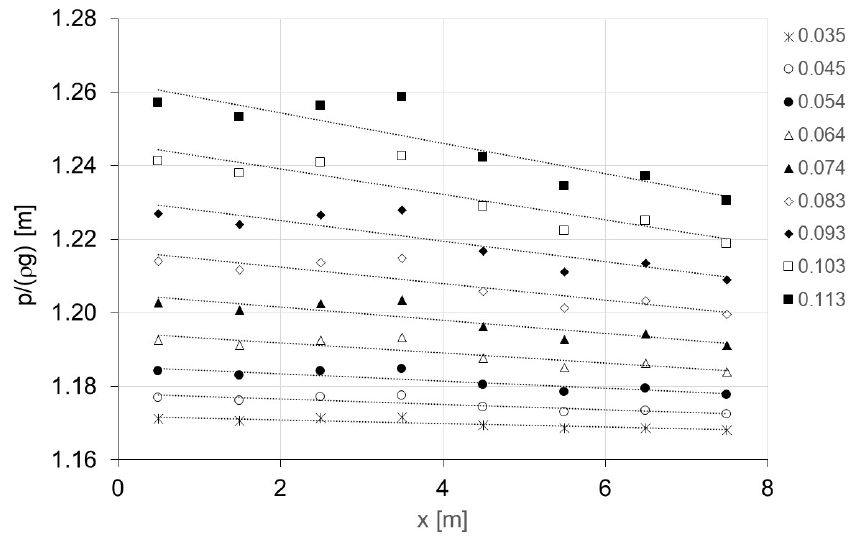
Figure 6. Pressure heads along the tunnel from the experimental investigations for the different discharges. The numbers in the legend indicate the model-discharge in [m 3 / s] and the dotted lines indicate a fitted straight line to the data points based on the data from cross sections 1–8.